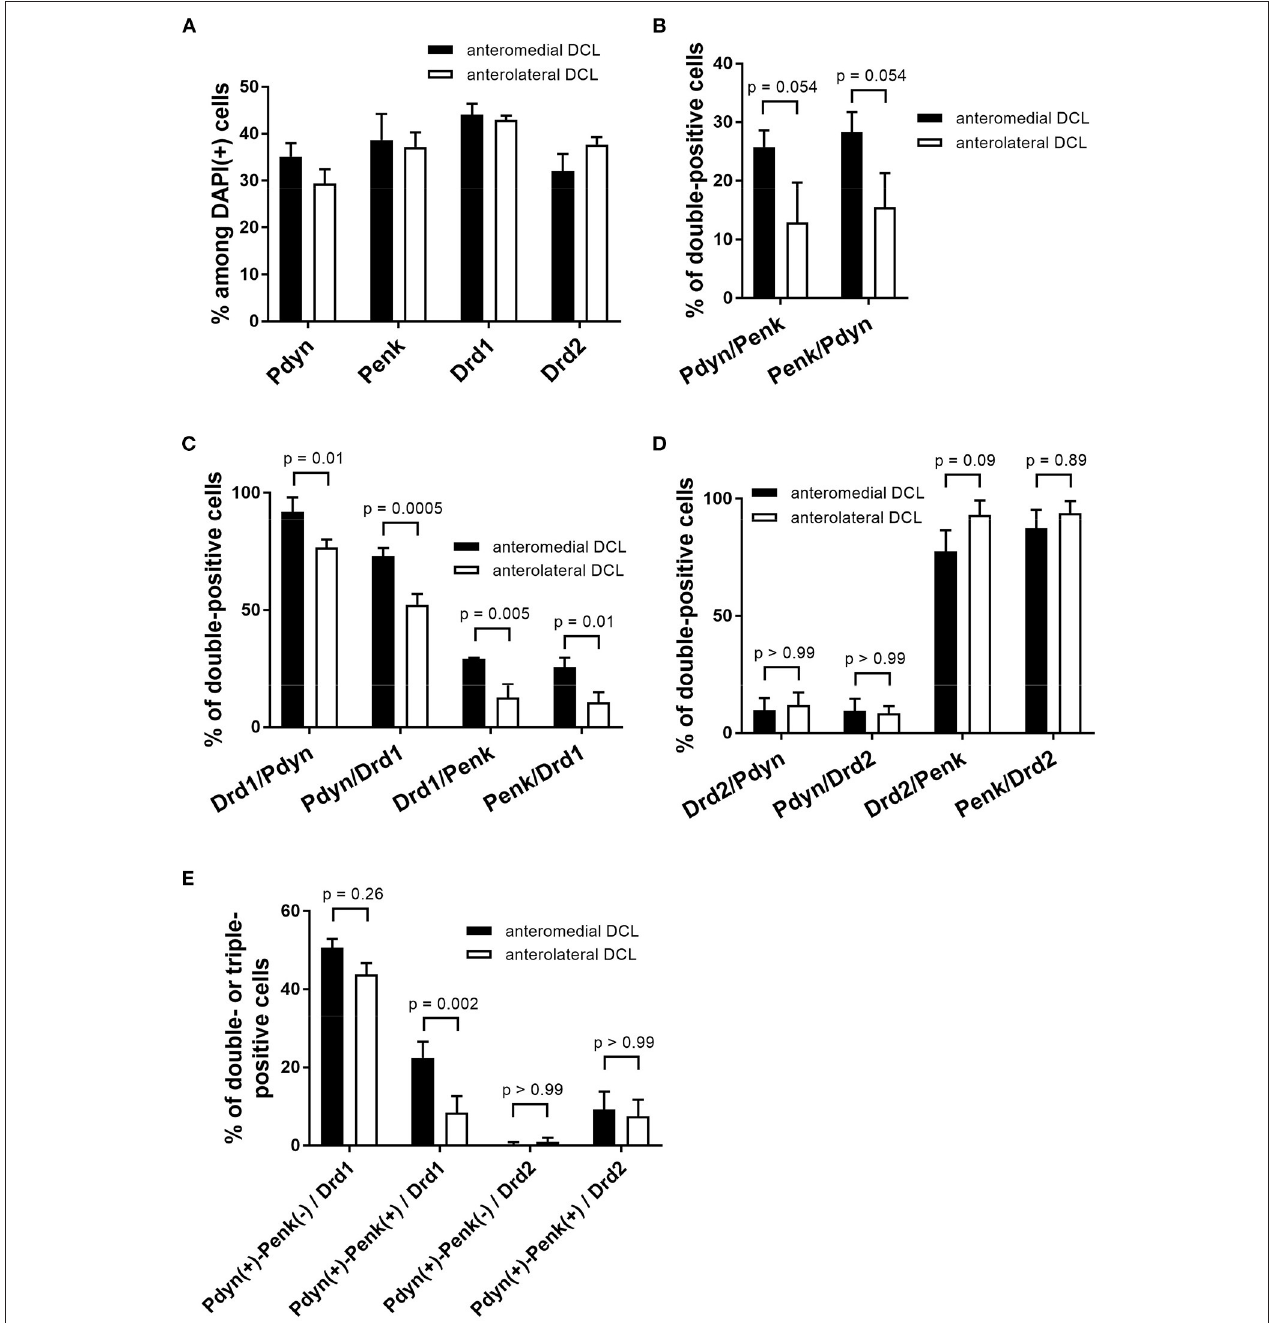
FIGURE 6 | Quantification of Pdyn, Penk, Drd1, and Drd2-expressing cells and their colocalization in the anteromedial and anterolateral OT DCL. (A) The percentages were calculated by dividing the number of Pdyn. Penk, Drd1, and Drd2-expressing cells by the number of the DAPI( + ) cells in the region of interest. The data of Pdyn and Penk were obtained from Pdyn-Penk-Drd1 co-staining images as shown in Figure 4 . (B–D) , The percentages of double-positive cells (e.g., Pdyn/Penk shows the percentage of Pdyn-Penk double-positive cells among Penk positive cells in the region of interest). The data in B were obtained from Pdyn-Penk-Drd1 co-staining images as shown in Figure 4 . (E) The percentage of triple-positive cells (e.g., Pdyn( + )-Penk(-)/Drd1 shows the percentage of the number of Pdyn( + ) and Penk(-) Drd1-expressing cells by the number of total Drd1 positive cells in the region of interest). Bars in the graphs represent mean ± SD. p -Values were calculated by post-hoc Tukey’s test after two-way ANOVA. n = 3